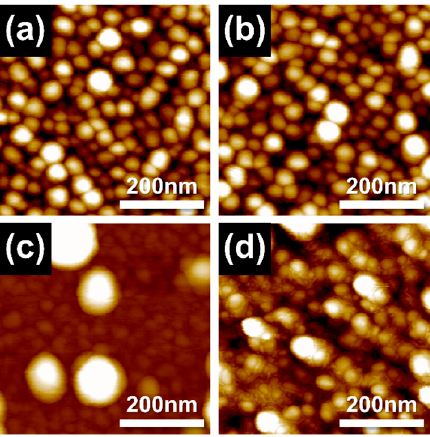
Figure 4. SEM micrographs of 100-nm-thick Ag-SDC cermet cathodes deposited under DC and RF powers of ( a ) Ag100-SDC50, ( b ) Ag60-SDC50, ( c ) Ag20-SDC50, and ( d ) Ag20-SDC80 on YSZ sub- strate.